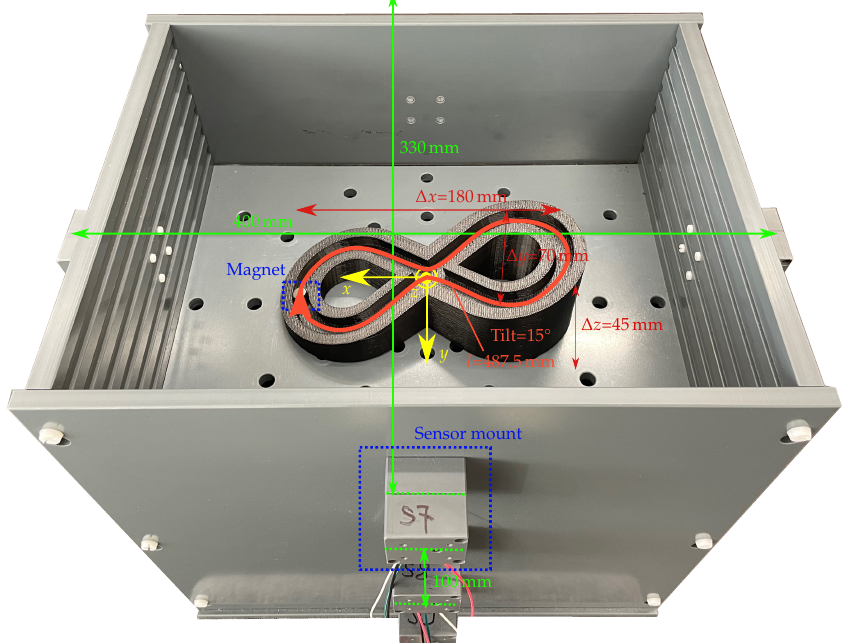
Figure 2. Localisation setup with the 12 sensors centered within the sensor mounts. The coordinate system of the setup is in its centre. The printed trajectory with the 10 placed at the z = 0 mm